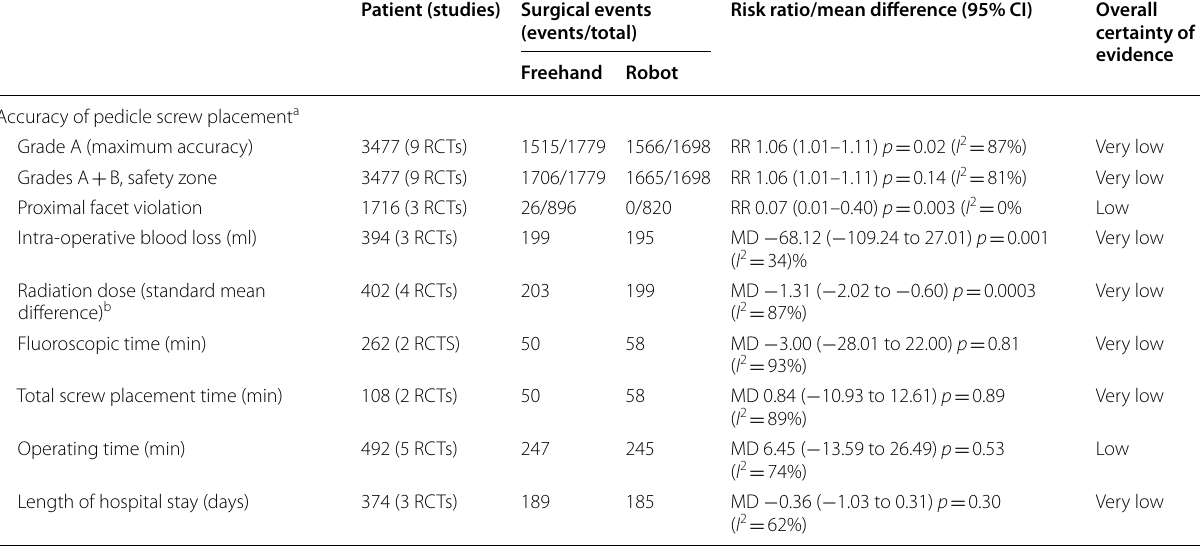
Table 4 Main findings of studies included in